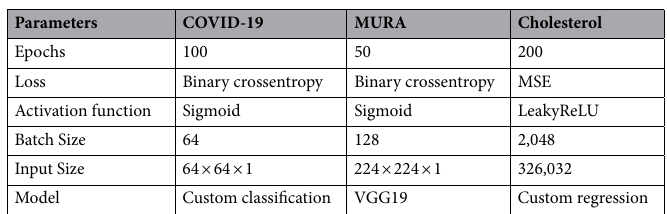
Table 1. The arrangements for a deep learning model to train each of the COVID-19, MURA and cholesterol data sets.